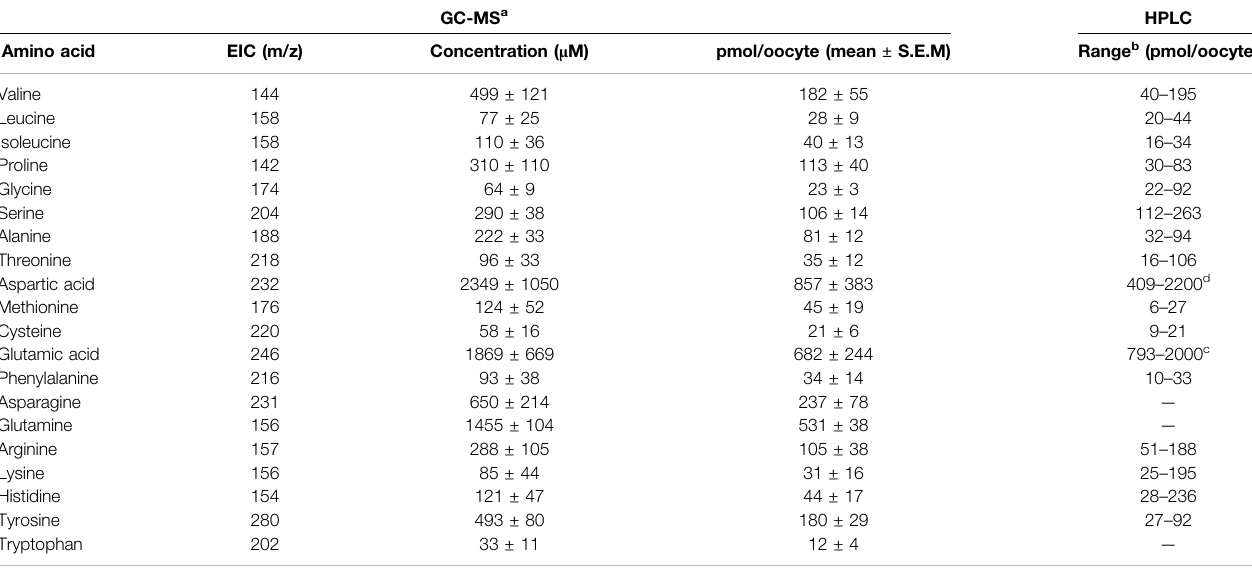
TABLE 1 | Free endogenous amino acid pools in stage 5 and 6 Xenopus laevis